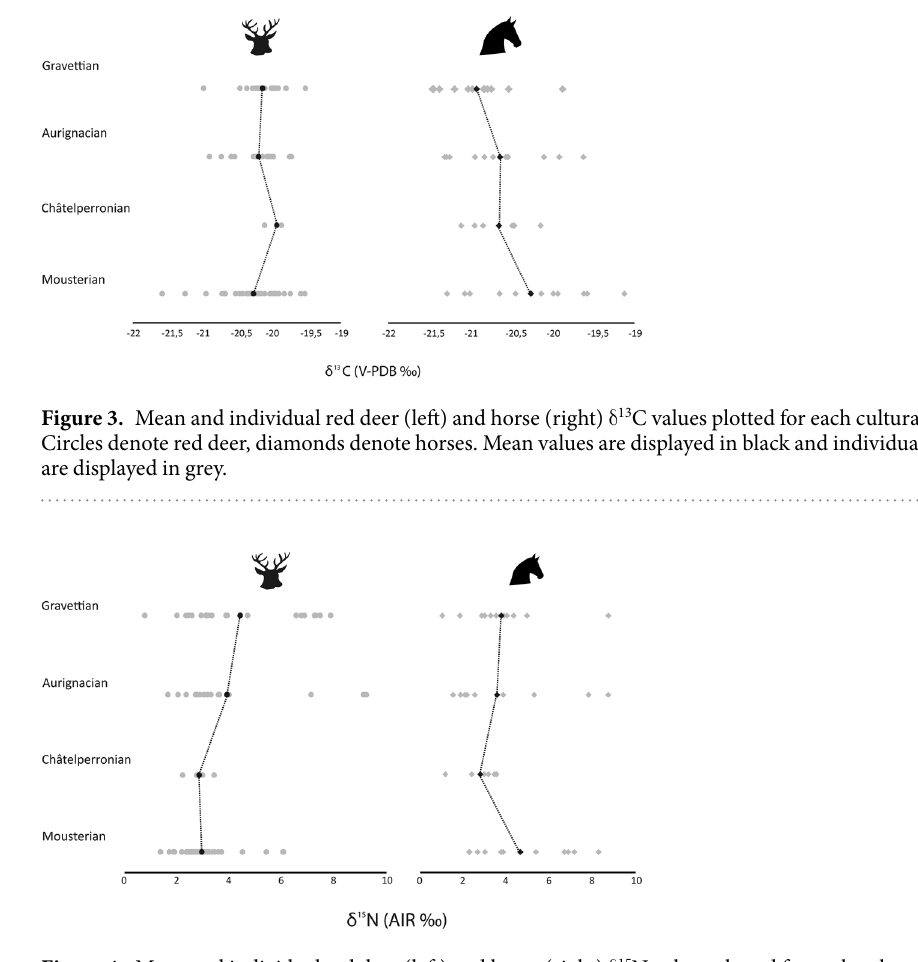
Figure 4. Mean and individual red deer (left) and horse (right) δ 15 N values plotted for each cultural period. Circles denote red deer, diamonds denote horses. Mean values are displayed in black and individuals sampled are displayed in grey.